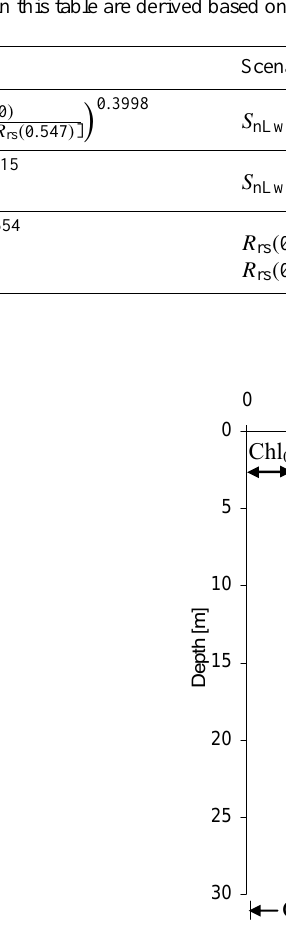
Figure 3. Schematic diagram represents the vertical profile of the chlorophyll along the depth including the distribution of profile pa- rameters using the Gaussian distribution